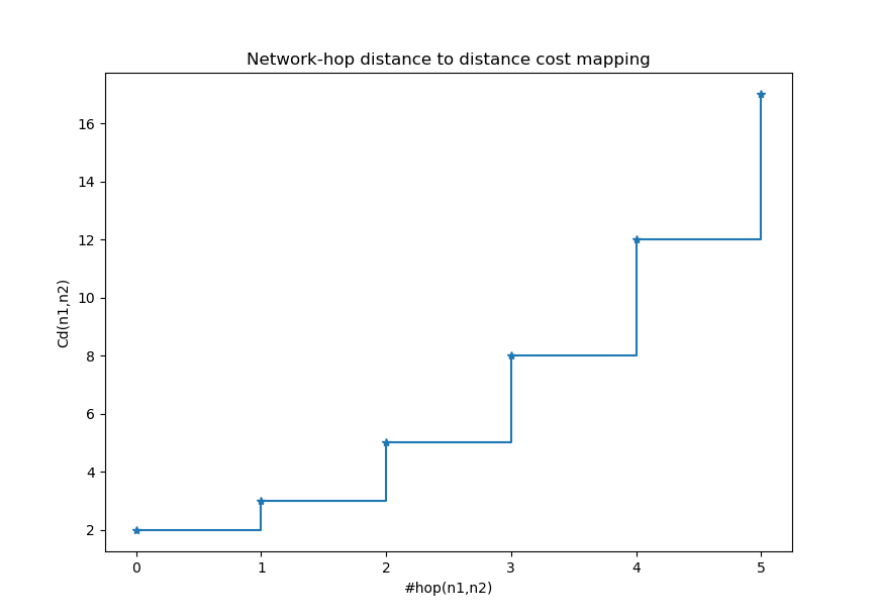
Figure 7. Network hop count between two nodes n 1, n 2 to distance cost mapping for the bid with β d =